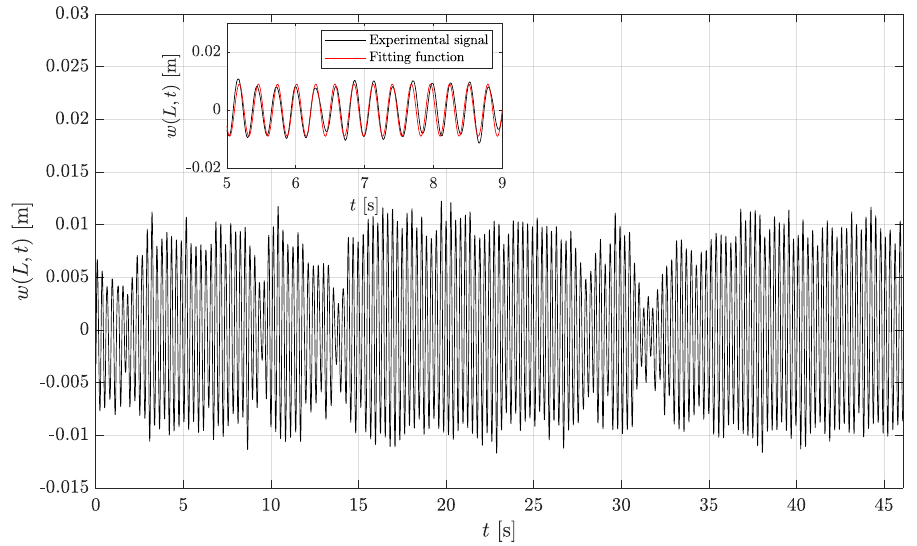
Figure 4. Experimental signal: transverse displacement of beam tip. The inset shows the overlapping of the harmonic fitting function with the experimental recording for the time interval 5 s < t < 9